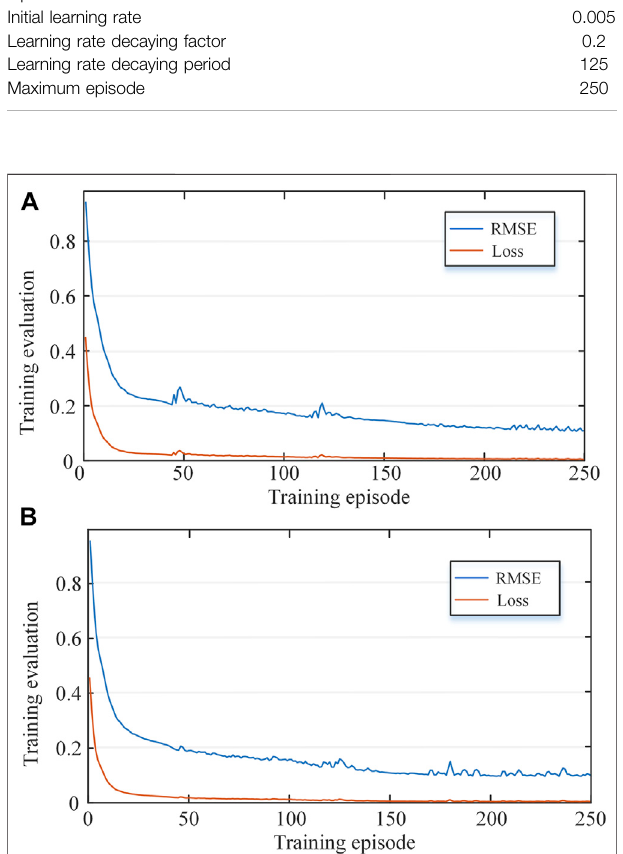
FIGURE 8 | Of fl ine training error. (A) Scenario I. (B) Scenario II.